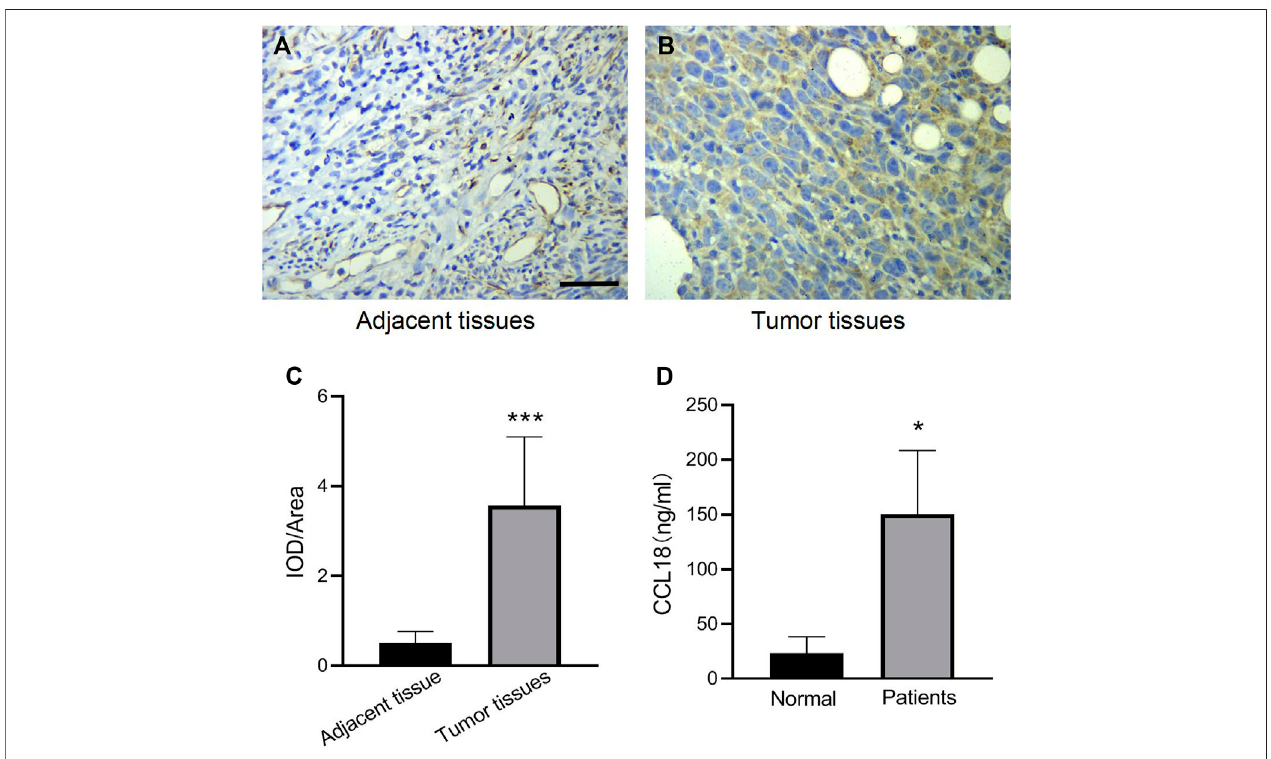
FIGURE 1 | The expression of CCL18 in UCs patients was higher than that in normal subjects. (A,B) is the result of CCL18 immunohistochemistry in UCs tissues and adjacent cancers (400 x). (C) isthe statistical result ofthe optical density of immunohistochemistry. (D) isthe expression ofCCL18 in theserum ofUCs patientsand